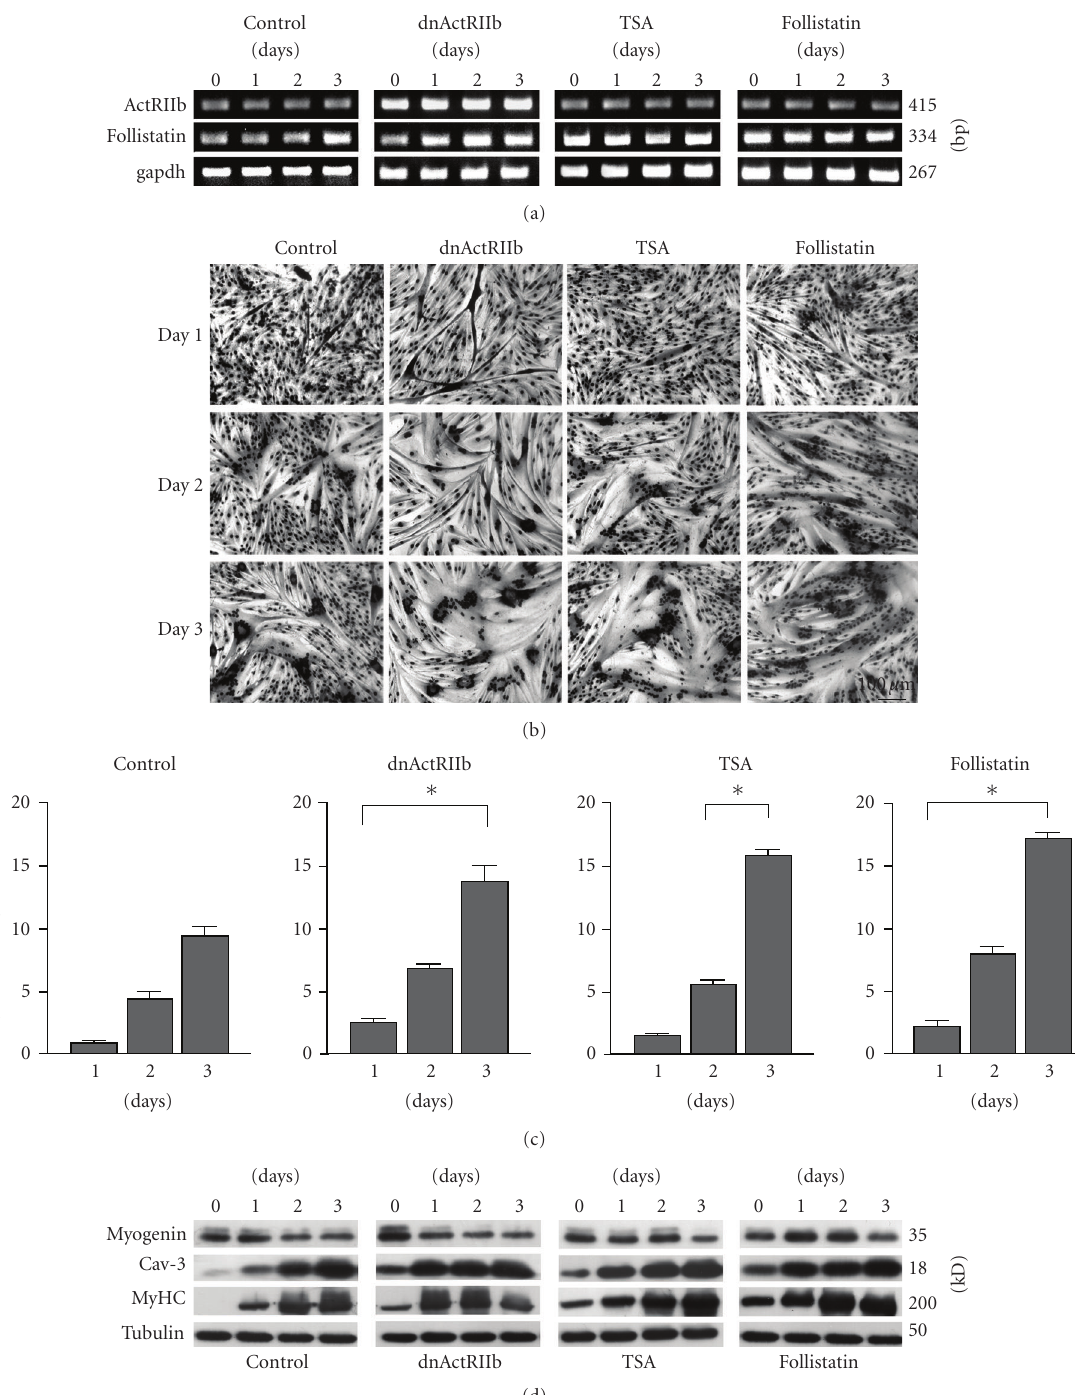
Figure 3: (a) Semiquantitative RT-PCR analysis was carried out to detect the levels of ActRIIb and follistatin levels in untransfected L6E9 (control) and in cells stably transfected with the dnActRIIb form, treated with TSA, or alternatively transfected with a short human follistatin form. Gapdh amplification was performeds as loading control. (b) Phase contrast pictures show the morphology of L6E9 cells after delivery of a dnActRIIb form, exposure to histone deacetylases inhibitor TSA, or stable follistatin overexpression, as compared to control cells. After Giemsa staining, pictures were taken under the same magnification over a time-course of 3 days. Bar = 100 μ m. (c) The graphs report the quantification of the myotube size in L6E9 cells transfected with dnActRIIb, treated with TSA or overexpressing follistatin as compared to control over a 3-day time-course di ff erentiation. ∗ P < . 05 versus control. (d) Immunoblotting was performed to detect the protein levels of myogenin, Cav-3, and MyHC in L6E9 expressing the dnActRIIb form, exposed to TSA or alternatively transfected with follistatin compared to control cells. Tubulin was used as loading